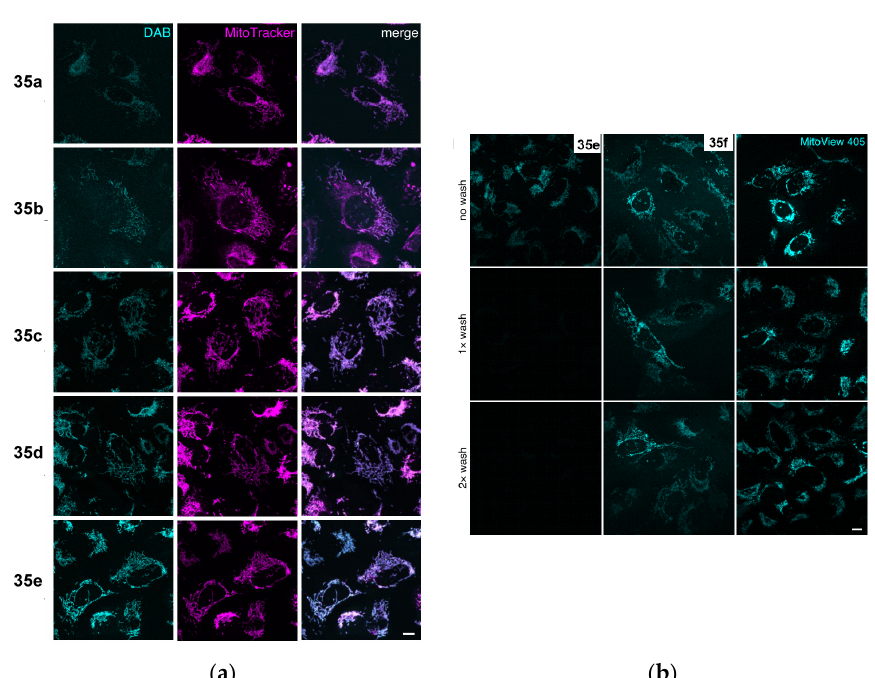
Figure 29. ( a ) Confocal fluorescence images of U2OS cells stained with DAB dyes 35a – e and MitoTracker Deep Red. ( b ) Confocal fluorescence images of live U2OS cells stained with DAB 35e , diDAB 35f , and MitoView 405 after 0, 1, or 2 dye-free media exchange washes. Scale bar: 10 μ m. Adapted from [73].